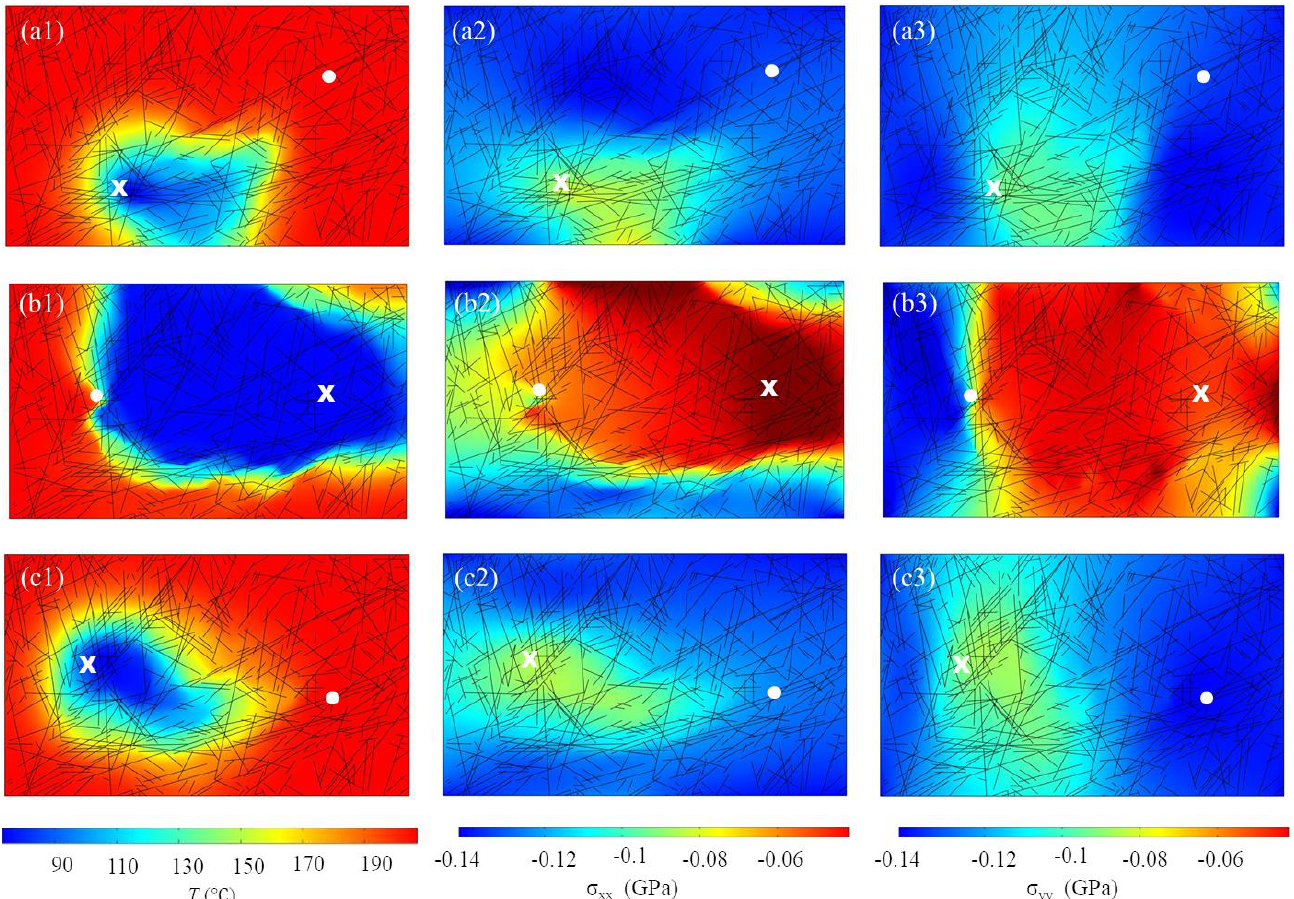
Figure 9. Distribution of ( a1 – c1 ) reservoir temperature, ( a2 – c2 ) horizontal thermoelastic stress and ( a3 – c3 ) vertical thermoelastic stress when CO 2 is used as the working fluid. Here Case 40 is displayed by ( a1 – a3 ), Case 180 is displayed by ( b1 – b3 ), and Case 350 is displayed by ( c1 – c3 ). All contours are plotted at 100 years. The injection wellbore position is shown by cross symbol whereas a circle indicates production wellbore position.